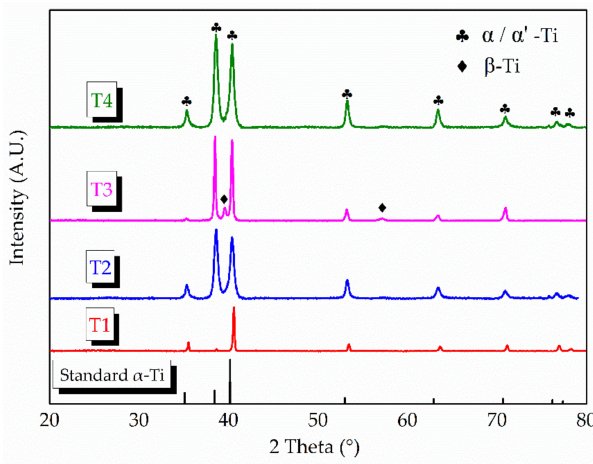
Figure 9. XRD patterns of the four samples compared with the standard hcp α -Ti peak.